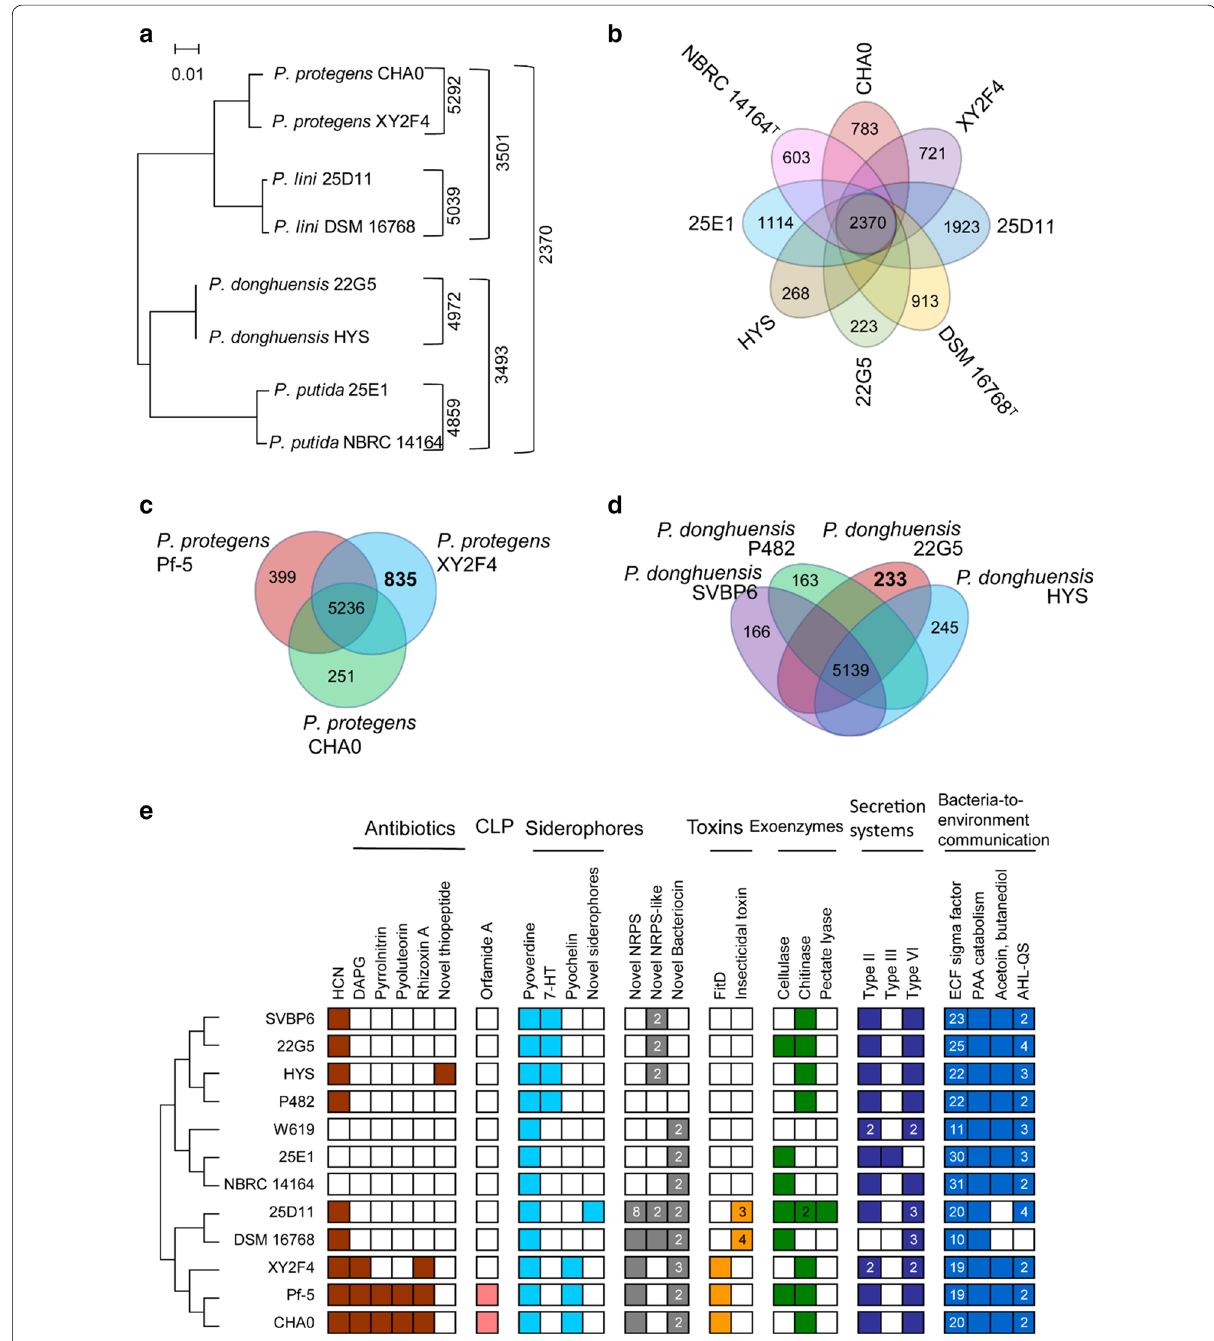
Fig. 3 Comparative genome analysis of Pseudomonas strains. a , b Number of shared genes and unique genes in genomes and of P. protegens XY2F4, P. donghuensis 22G5, P. putida 25E1 and P. lini 25D11 and their type strains. c , d Number of unique genes in P. protegens XY2F4XY2F4 and P. donghuensis 22G5 when compared with published strains from the same species (with NCBI accessions). e Presence of selected gene clusters for biosynthesis of antibiotics, cyclic lipopeptides (CLP), siderophores, insecticidal toxins, exoenzymes, secretion systems, and chemicals for bacteria-to-environment communication. Colored box/blank box indicates the presence/absence of selected gene clusters, respectively. Numbers within boxes represent the predicted number of gene clusters encoded for the corresponding